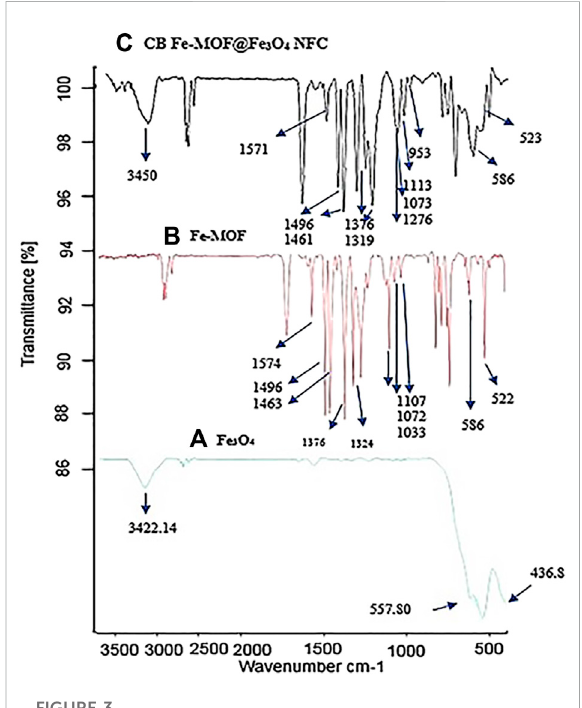
FIGURE 3 IR (KBr, υ /cm − 1 ) curve of (A) Fe 3 O 4 , (B) synthesized Fe-MOF, and (C) CB Fe-MOF@Fe 3 O 4